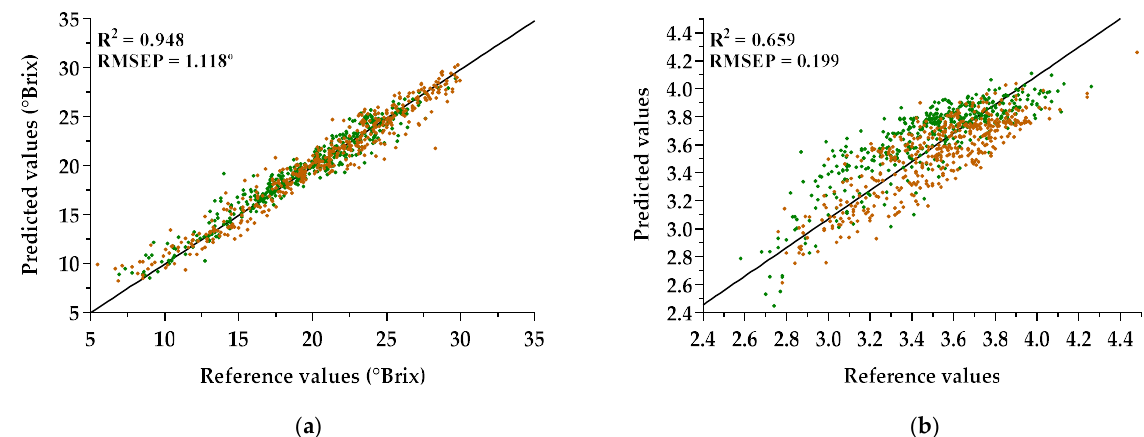
Figure 5. Prediction results of the independent test set with samples of the varieties TN (green points) and TB (orange points) when introduced into the 1D CNN model created with TF samples, regarding ( a ) sugar measurements and ( b ) pH